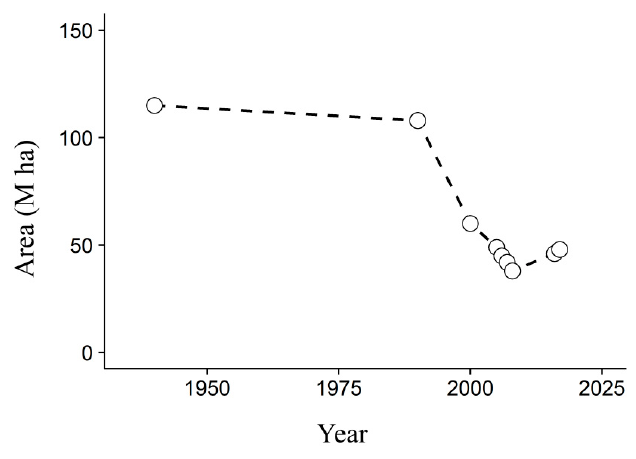
Figure 1. Area of arable lands in Yakutia from 1940 to 2017 [28].